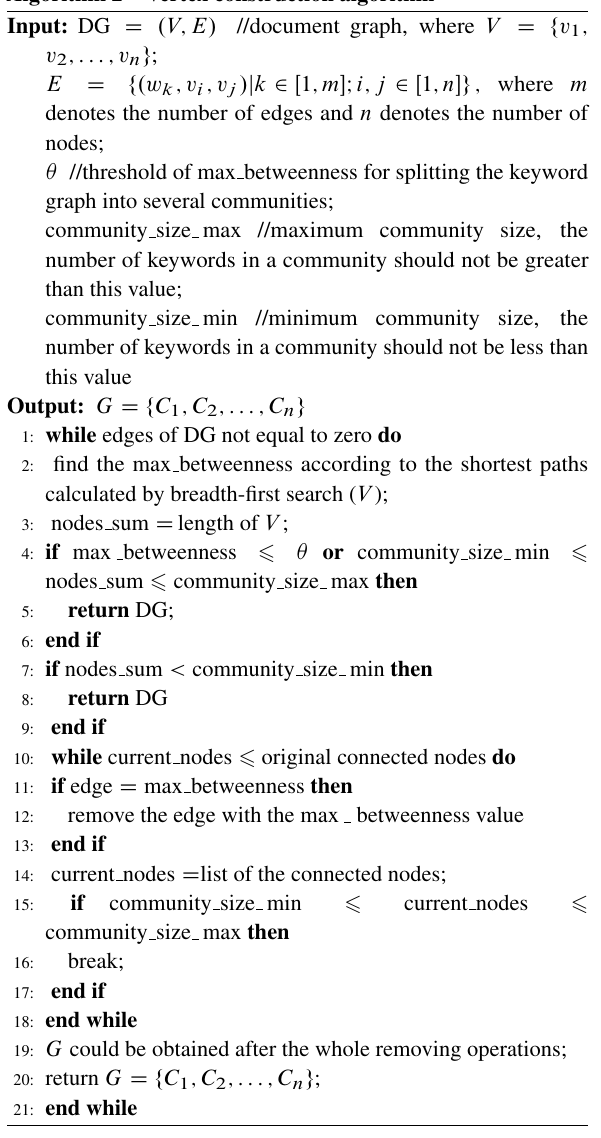
Algorithm 2 Vertex construction algorithm